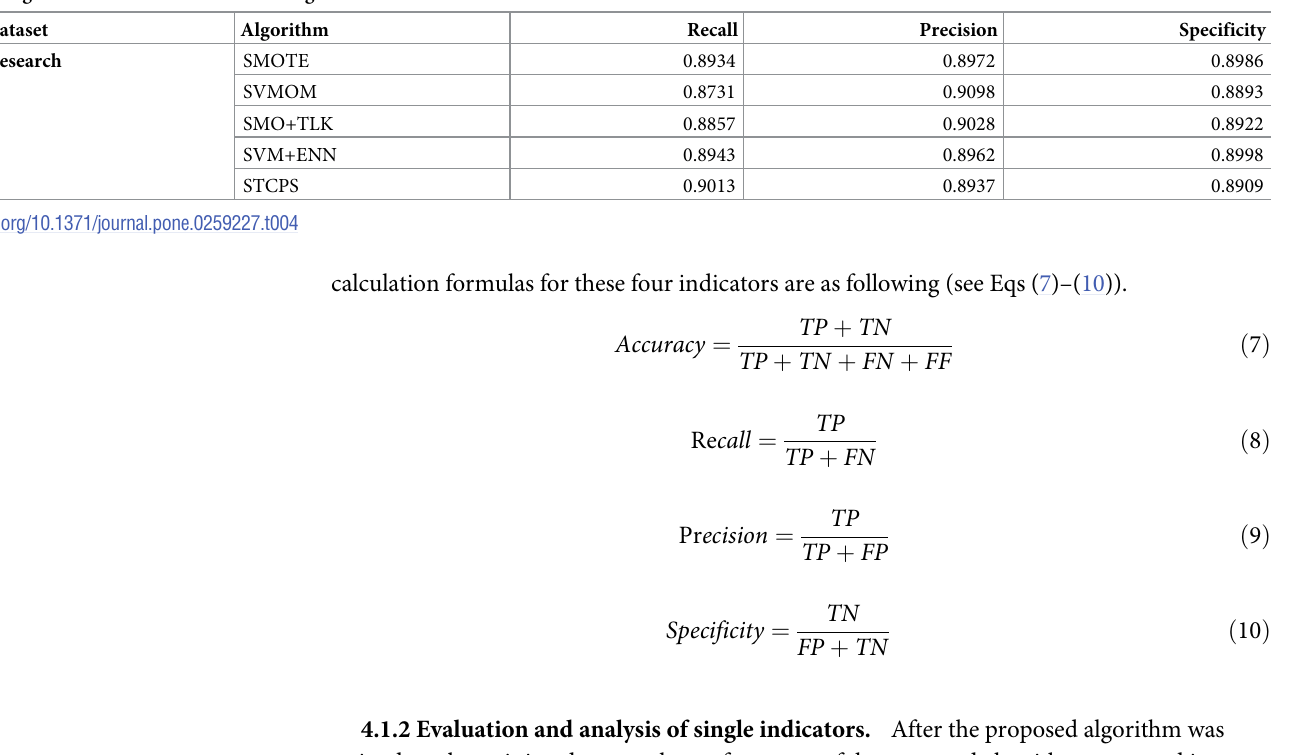
Table 4. Single index evaluation of different algorithms.